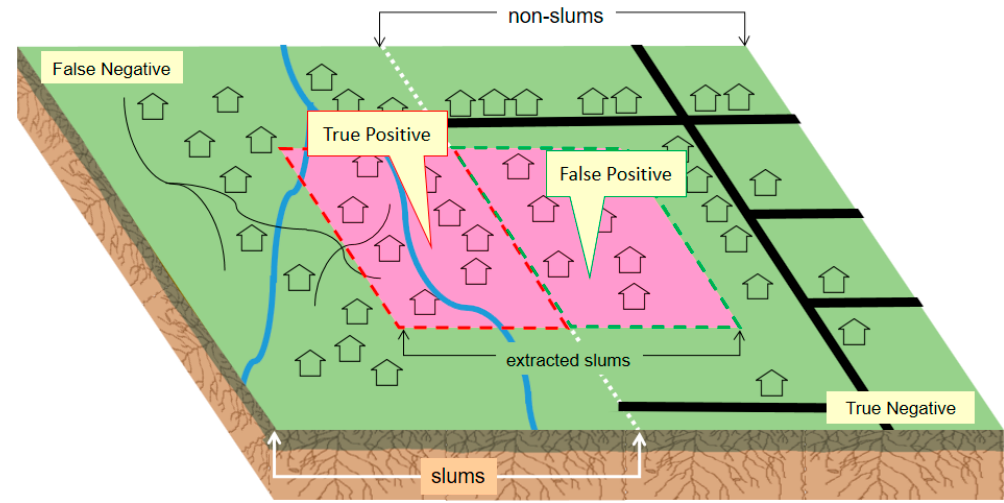
Figure 3. Four possible results from combining classification result with the reference data produced by the experts.